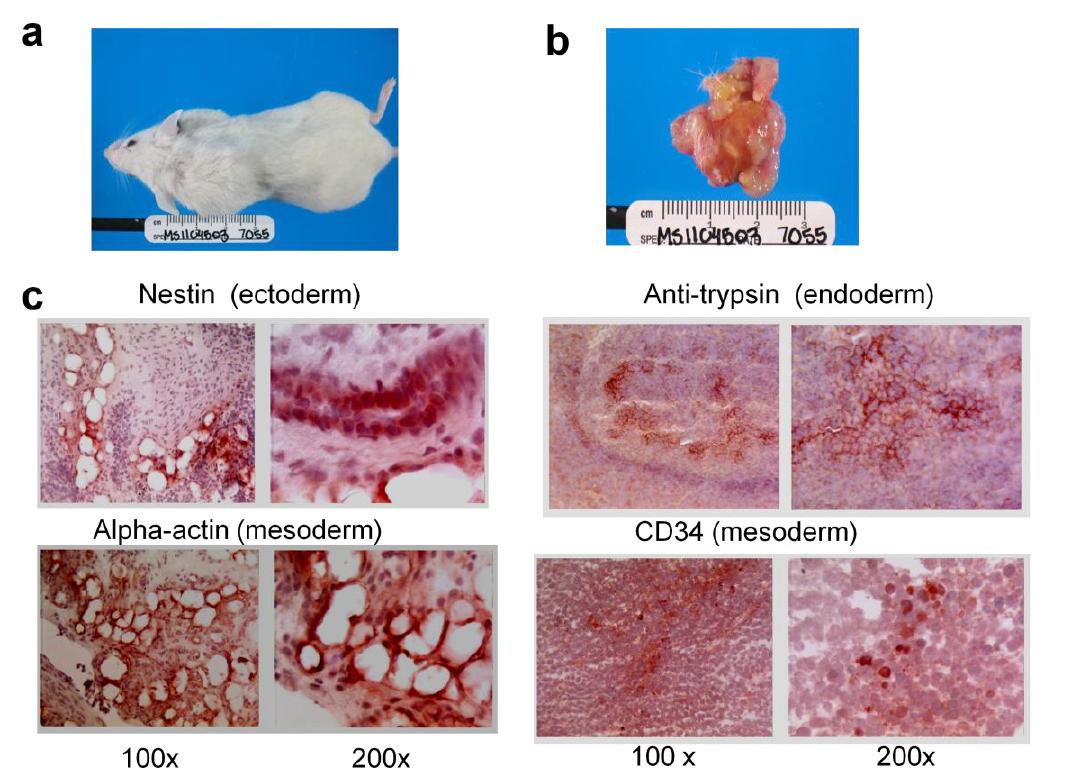
Figure 5. Characterization of tumors developed from iPSC. ( a ) Mouse with neck tumor. Representative picture is shown. ( b ) Isolated tumor. Representative picture is shown. ( c ) Characterization of tumor sections. Immunostaining for nestin , anti-trypsin, alpha-actin and CD34, red color. Hematoxyline (blue color) was used for